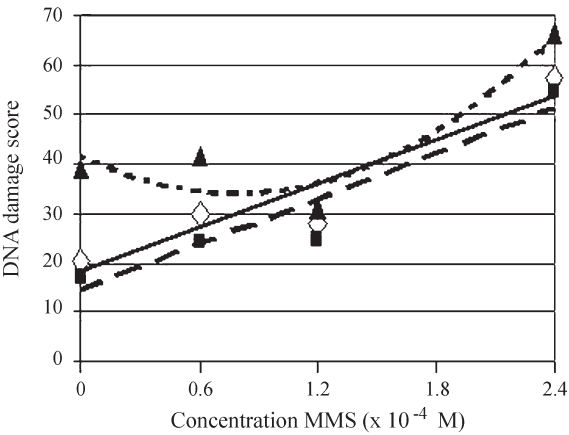
Figure 2 - Cell damage scores for hemolymph, digestive gland tissue and gill tissue after treatment with methylmethane sulfonate (MMS). Key: hemolymph ( (cid:2) — (cid:2) ), gill tissue ( (cid:1) - - - (cid:1) ), digestive gland ( (cid:1) - - - (cid:1) ). Mean values for 4 replicates. Hemolymph y = 14.821x + 18.25/ R 2 = 0.882. Di- gestive gland tissue y = 15.508x + 14.05/ R 2 = 0.8959. Gill tissue y = 12.216x 2 - 19.33x + 41.645/ R 2 =